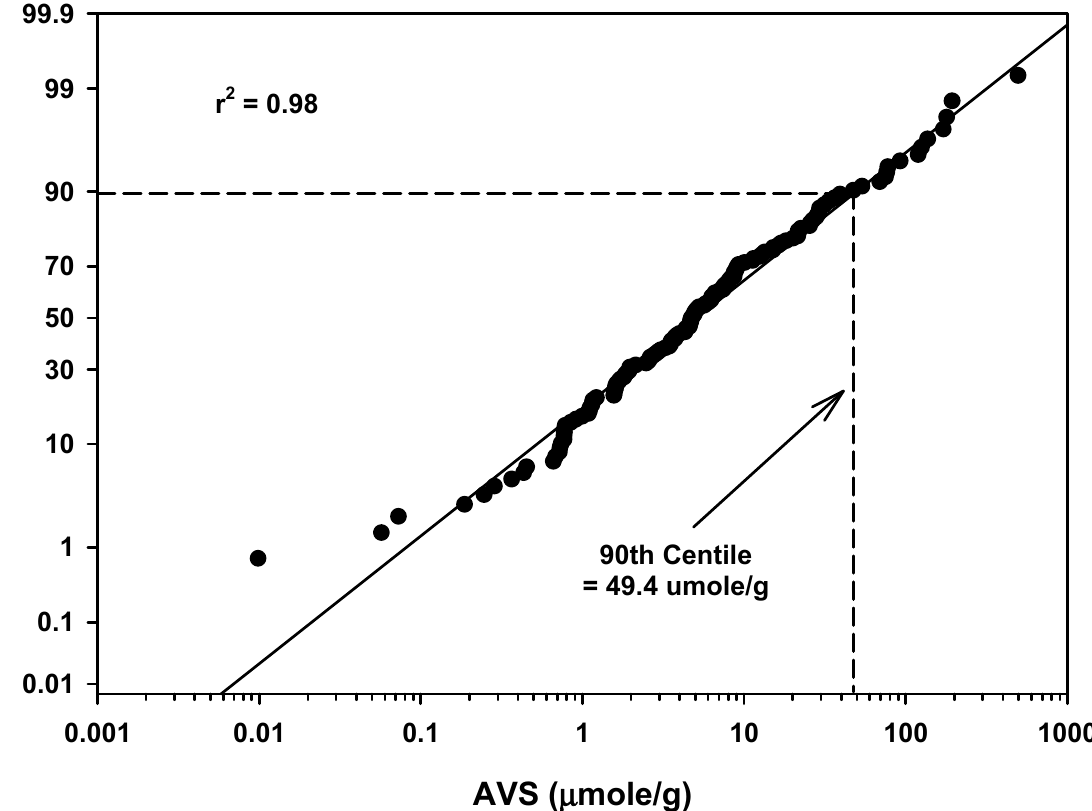
Figure 9. Regression of AVS field study means data for all waterbodies against a probability scale showing the 90th centile rank.